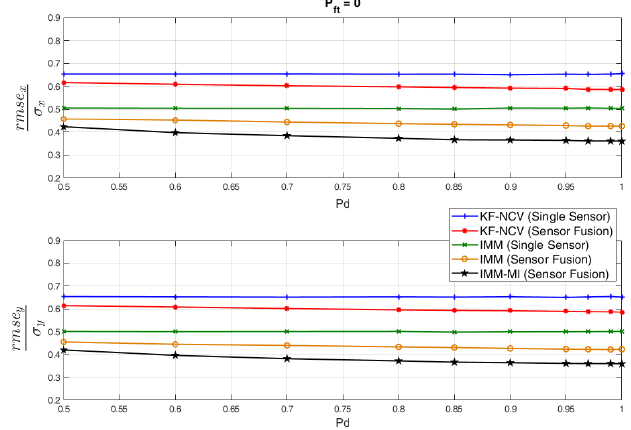
Figure 8. Comparison of the normalized positioning RMSE averaged over the entire simulation vs. P d , with respect to the x -axis (top) and the y -axis (bottom), over a simulated move-stop-move target for P ft = 0.